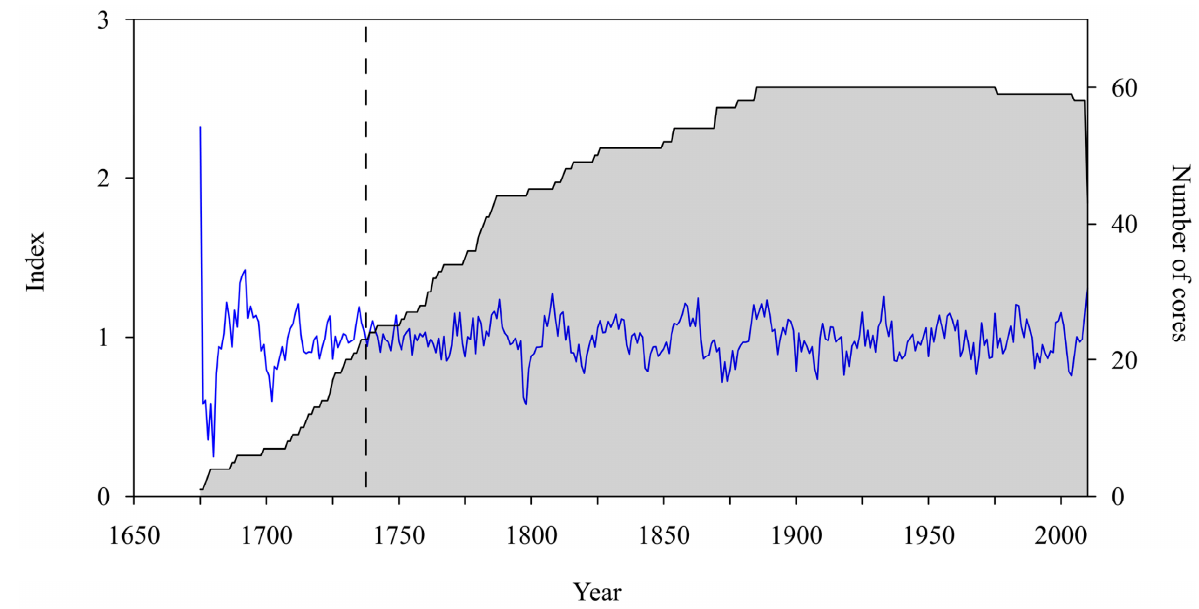
Figure 2. The tree ring width and number of tree rings. The red arrow indicates that the first year of EPS > 0.85.